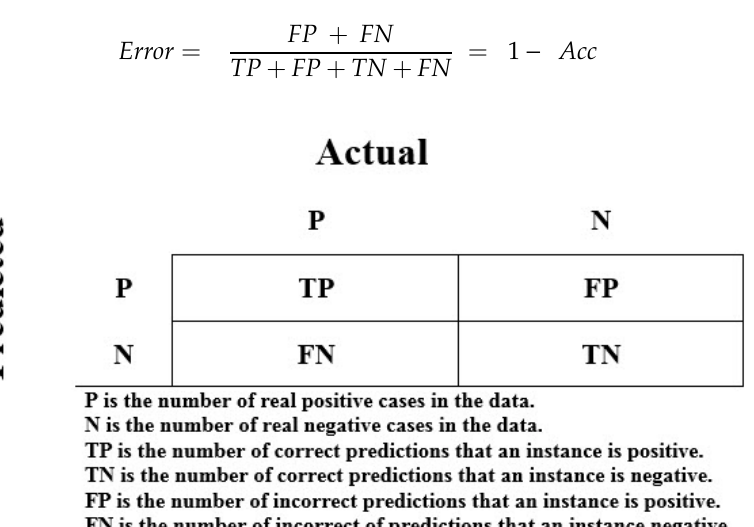
Figure 5. The basic form of confusion matrix with two classes.